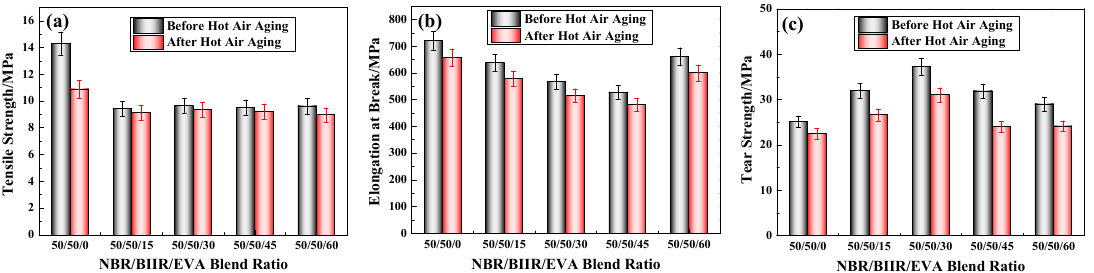
Figure 15. Storage modulus E ′ versus temperature of NBR/BIIR/EVA with various blend ratios.